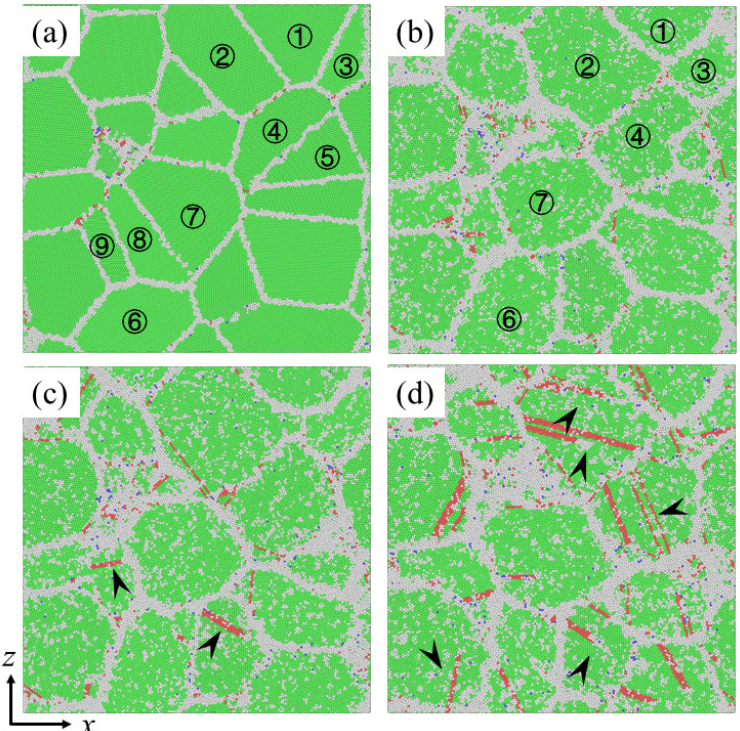
Figure 5. Snapshots of a pure Ni sample with d = 10.9 nm at 1100 K ( a ) before creep; ( b – d ) after creep for 200 ps under an applied stress of 0.6 GPa, 1.0 GPa and 1.6 Gpa, respectively.